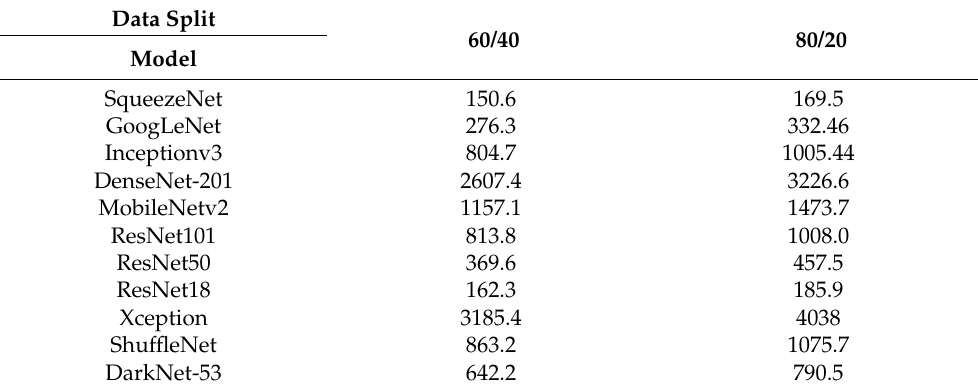
Table 6. Time results in various performance evaluation scenarios. All times are averages of 10 runs and in